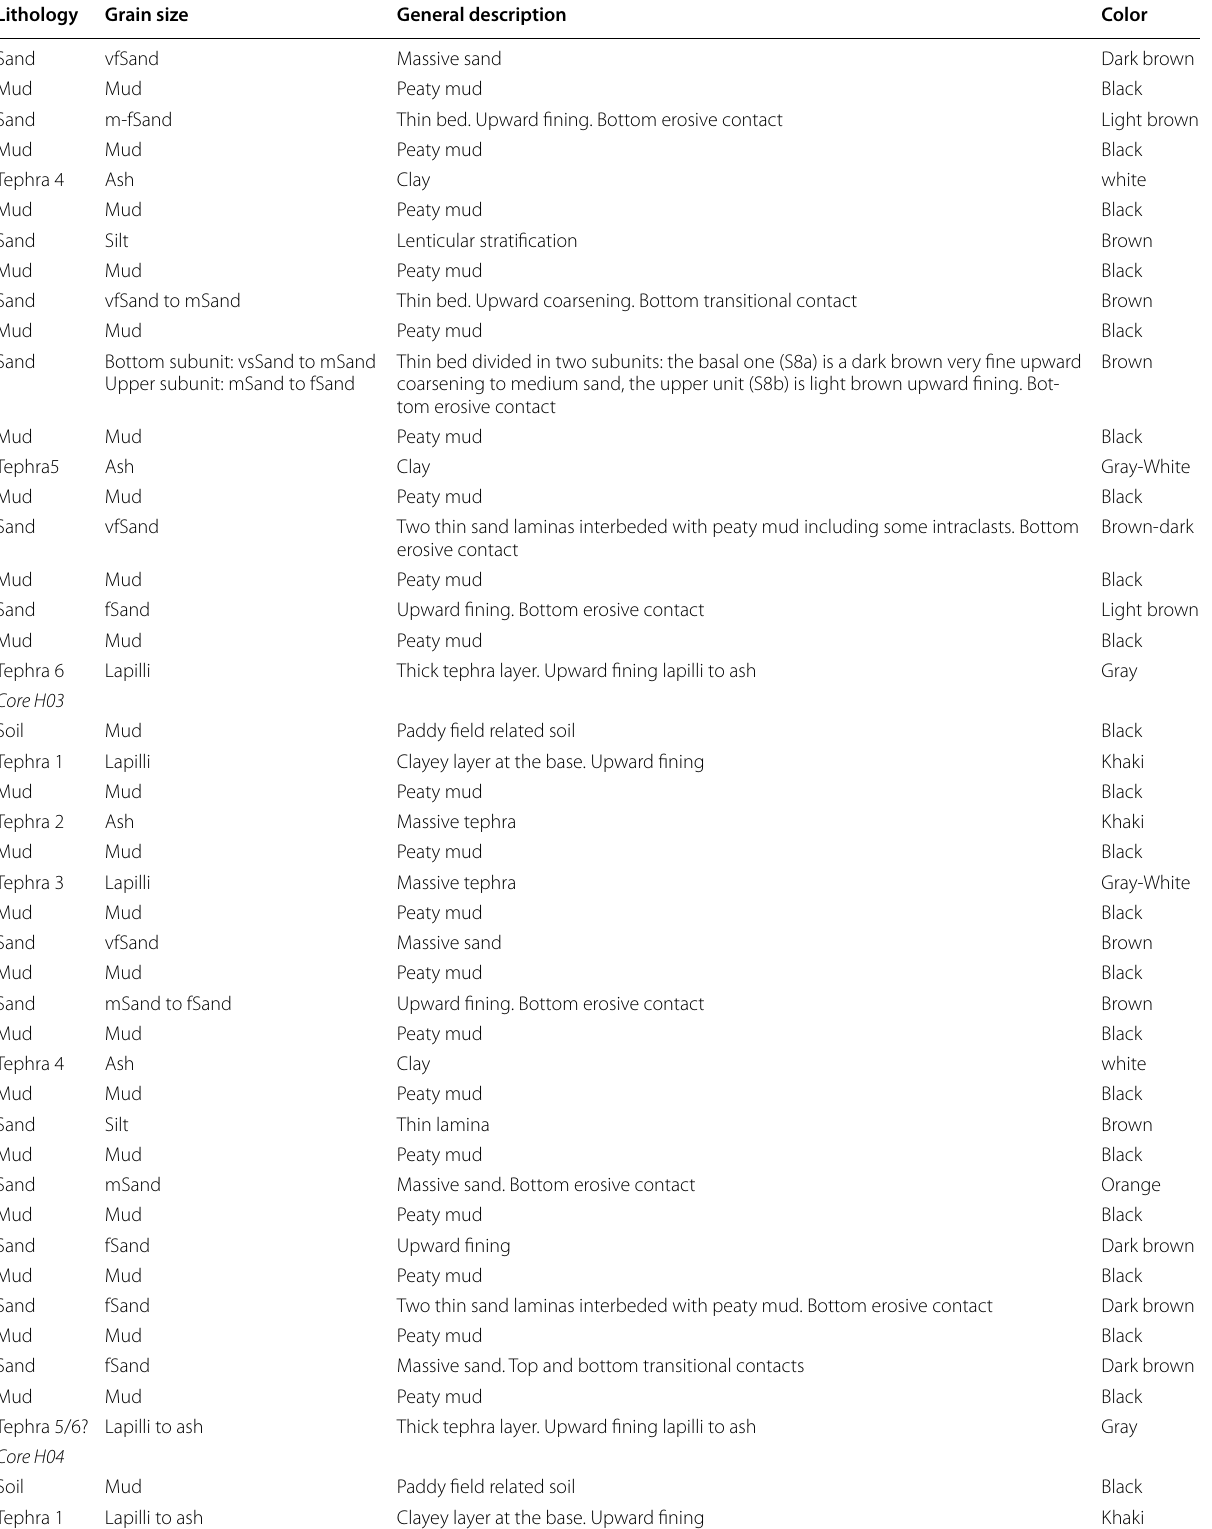
Black Brown Brown‑dark Black Black Black Brown Black Black Black